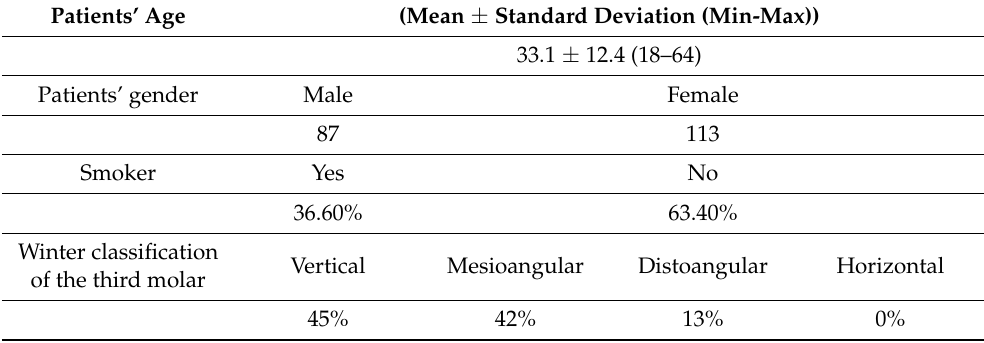
Table 1. Baseline characteristics of the treated population.